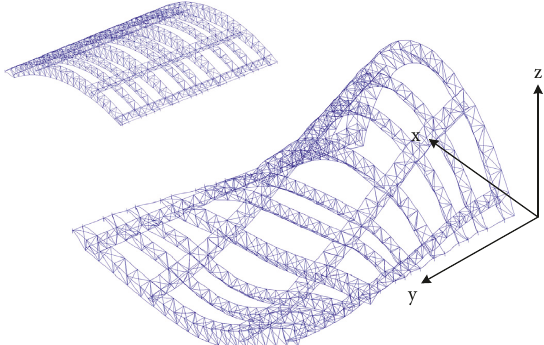
Figure 17: The 5th mode shape (vertical).